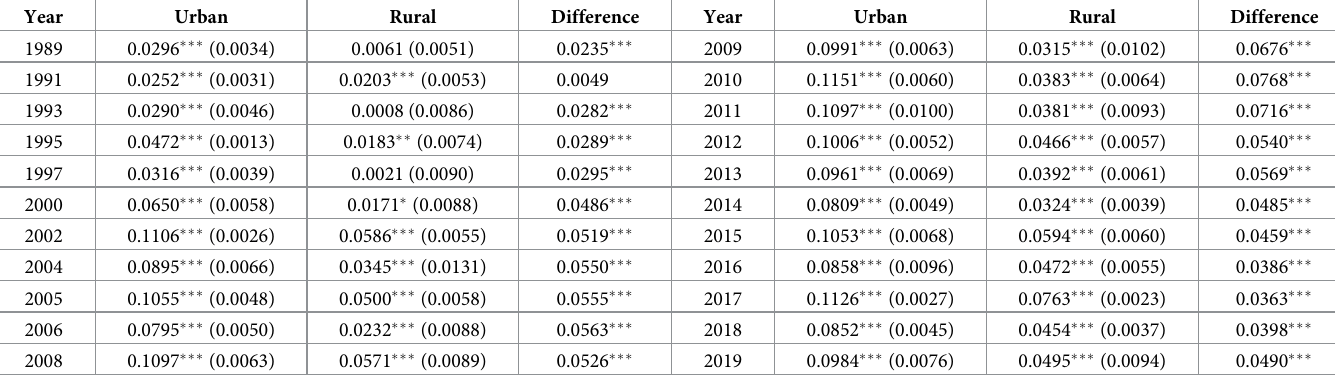
Table 2. Differences in returns to education between urban and rural China (OLS